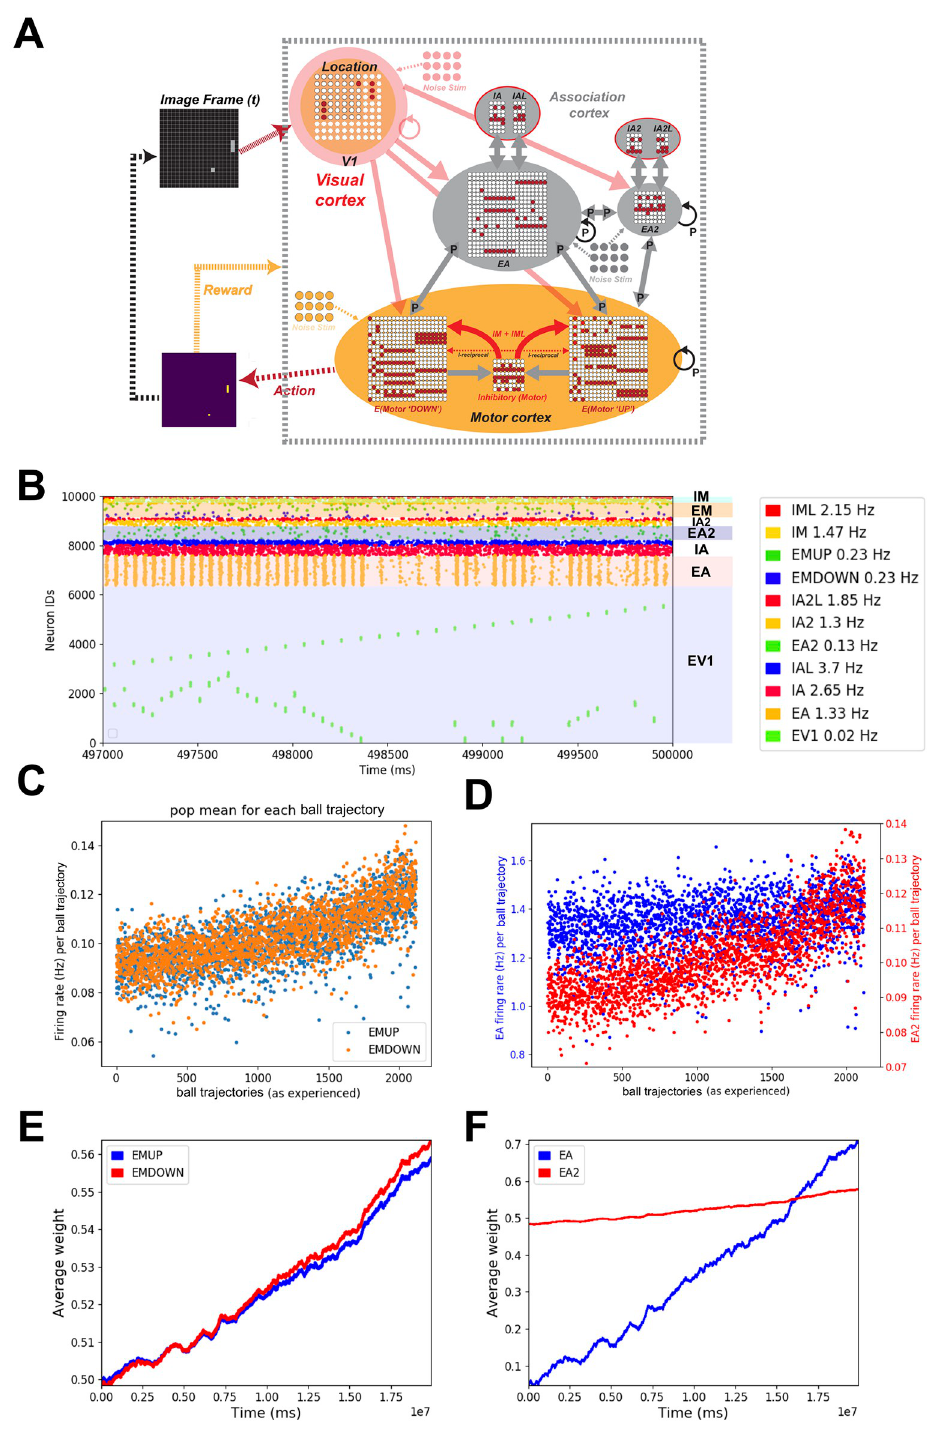
Fig 7. The synaptic weights of the recurrent spiking neuronal network model were adjusted to ensure reliable transmission of the input information across all network areas. A) The schematic shows the racket-ball game interfaced with the recurrent model of visual and motor areas. B) Raster plot showing the spiking activity of different populations of neurons during a training episode. C) Firing rates of motor neuron populations ‘EMUP’ and ‘EMDOWN’ in the recurrent model. D) same as in C for ‘EA’ and ‘EA2’. The firing rates in C and D were binned for ball trajectories (each ball trajectory from the extreme left to the right side of the court where the ball hits or misses the racket). E) Average weight change of synaptic input onto ‘EMUP’ and ‘EMDOWN’ sampled over 40 training episodes. F) same as in E for ‘EA’ and ‘EA2’ sampled over 40 training episodes.